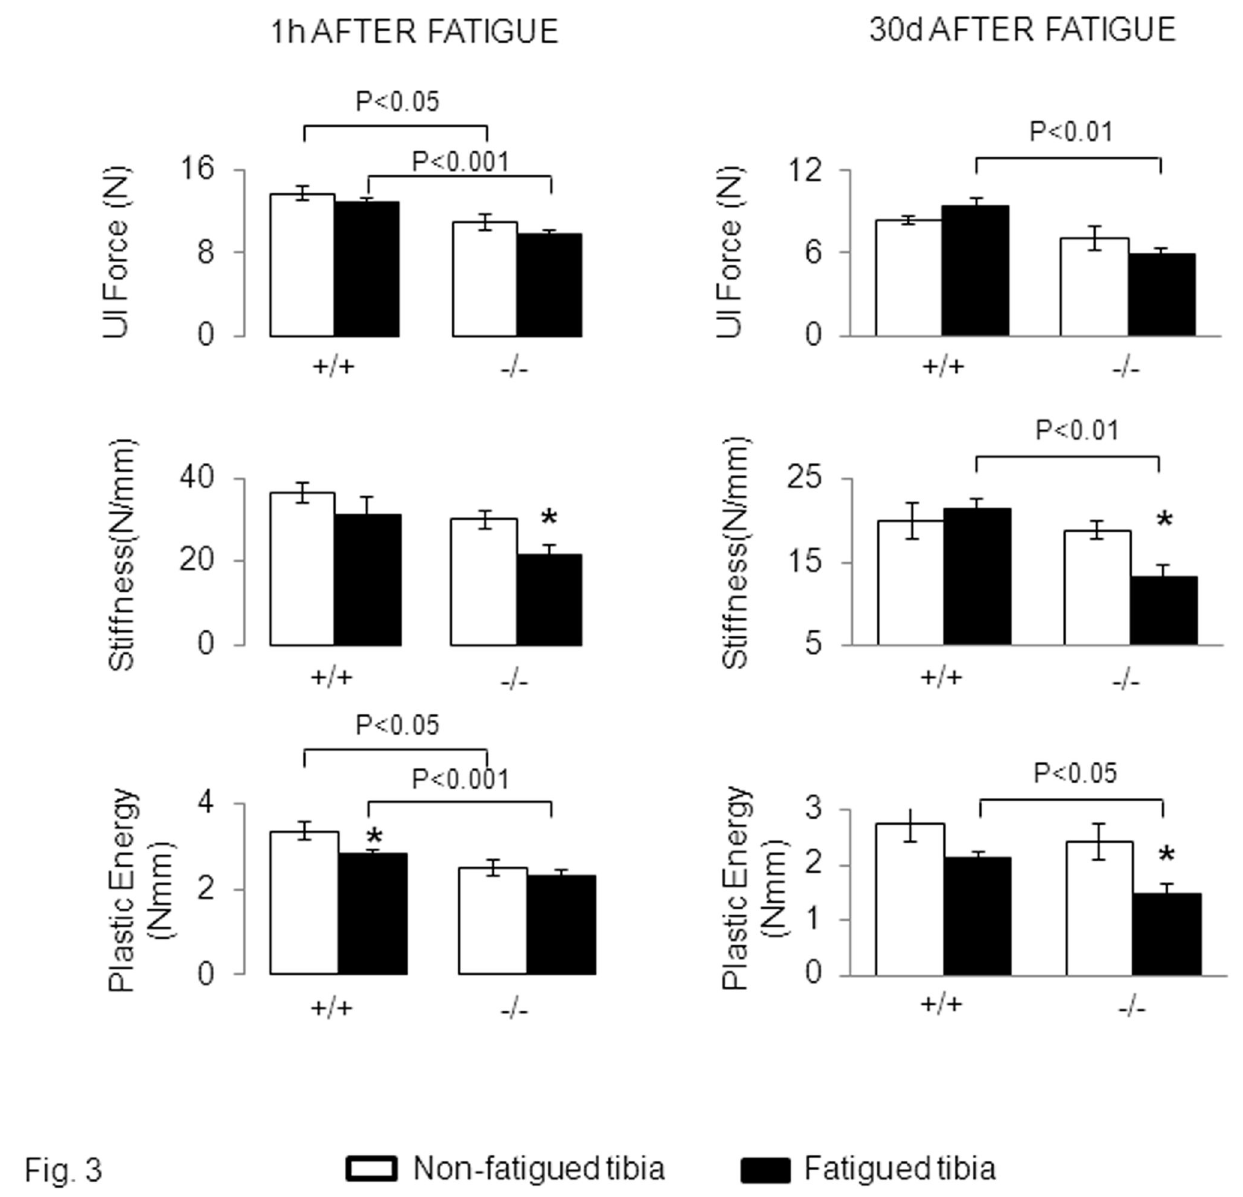
Figure 3. Effects of fatigue loading on bone mechanical properties in Postn -/- and Postn +/+ mice. Biomechanical properties of the cortical tibia evaluated by three point bending, 1 hour and 30days after fatigue. Group differences were determined by post-hoc Fisher’s PLSD following 2F-ANOVA (fatigue-genotype). * p<0.05 compared to the non-fatigued tibia. Bars show mean (± sem) of n= 6-8 animals /